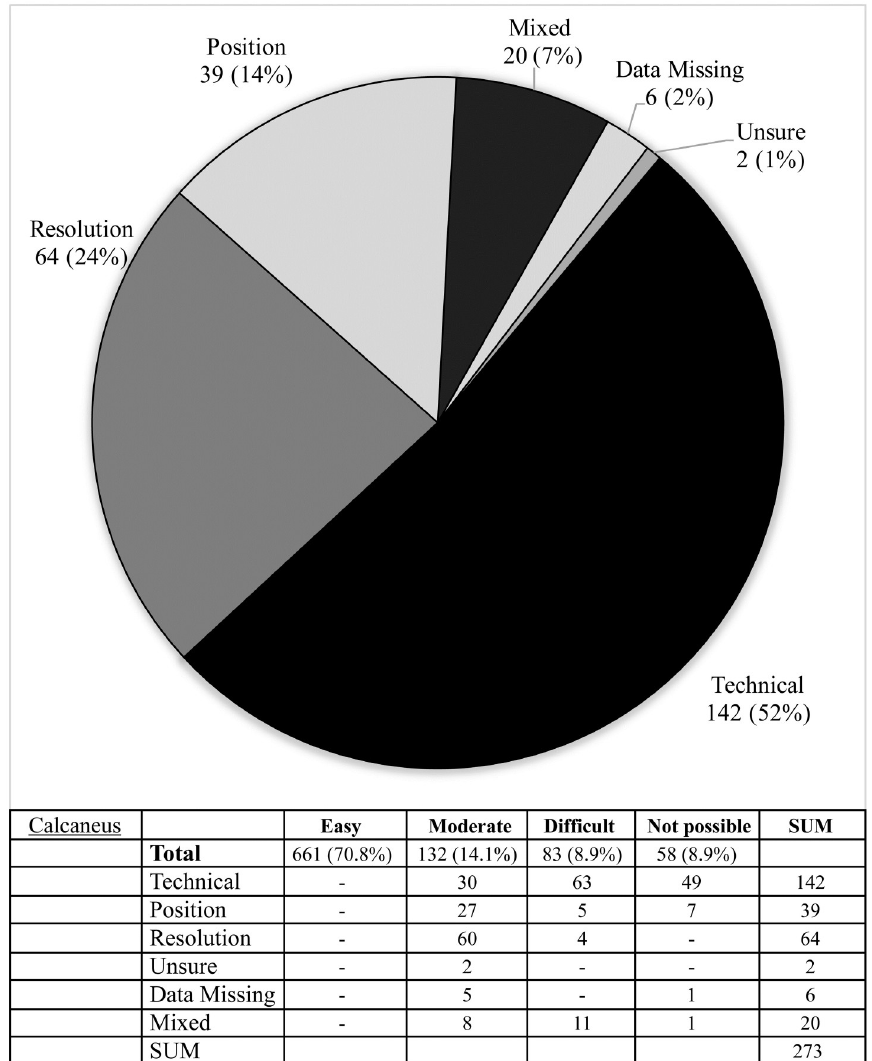
Fig 8. Difficulties reported during image assessment of the calcaneus method. Difficulties were grouped as those due to technical difficulties e.g. landmark(s) lying outside of the edge of the image; resolution issues, insufficient resolution to assess image easily; positioning—landmark not visible, or not clearly visible due to limb rotation or shadowing; and if rater was ‘unsure’ due to problems with method